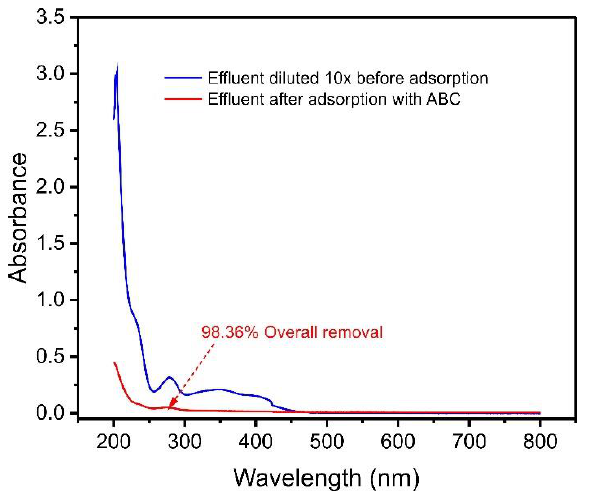
Figure 7. UV – VIS spectra of synthetic effluent before adsorption and after treatment with ABC biochar. For the composition of synthetic effluent, see Table S1.